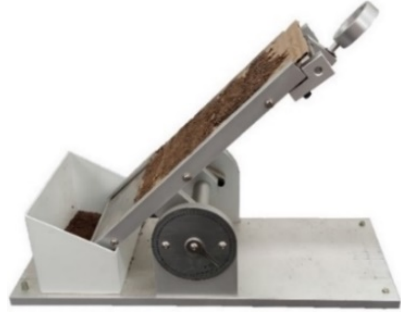
Figure 1. CNY-1 inclinometer. The soil rest angle was determined by using an FT-104B rest angle tester (Rooko Instrument Co., Ltd., Ningbo, Zhejiang.) (Figure 2), with funnel height of 140 mm, inlet diameter of 135 mm, and outlet diameter of 20 mm, and a tray with a diameter of 61.8 mm and height of 20 mm was placed directly below the funnel outlet.